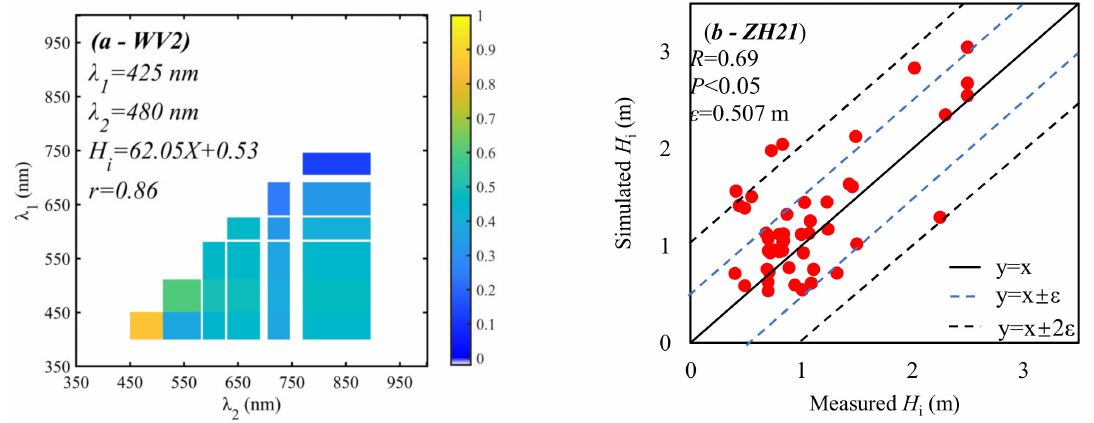
Figure 6. Panel ( a ) is OBRA of WV2 for H i . Panel ( b ) is the validation of underlying ice thickness retrieved by the ZH21 algorithm and in situ